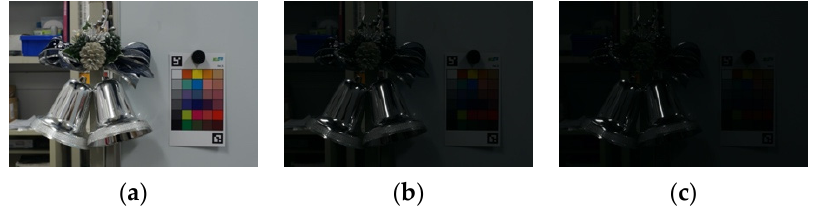
Figure 2. Images with different exposure times. ( a ) 1/8 s; ( b ) 1/60 s; ( c ) 1/125 s.